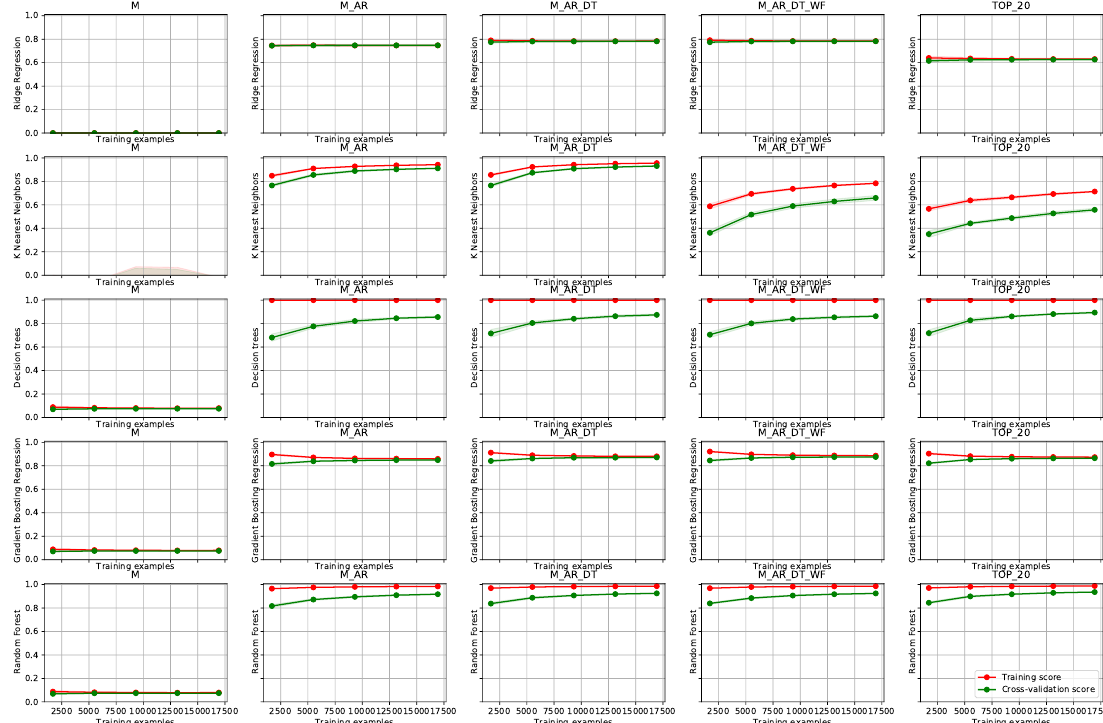
Figure 6. Learning curves on the smart grid use case. Columns depict five different feature vector definitions: M —measurements, M_AR —measurements and autoregressive features, M_AR_DT — measurements, autoregressive features and data-time features, M_AR_DT_WF —all of the features from M_AR_DT and weather forecasts, TOP_20 —best 20 features. The rows include results from different learning algorithms: ridge regression, k-nearest neighbours, decision trees, gradient boosting and random forest, respectively. Each sub-figure in the matrix presents a number of training examples on x axis and R 2 score in the y axis. The green line represents the learning curve on the test data. The red line represents the learning curve on the train data. The darker band around the curves depicts standard deviations of the R 2